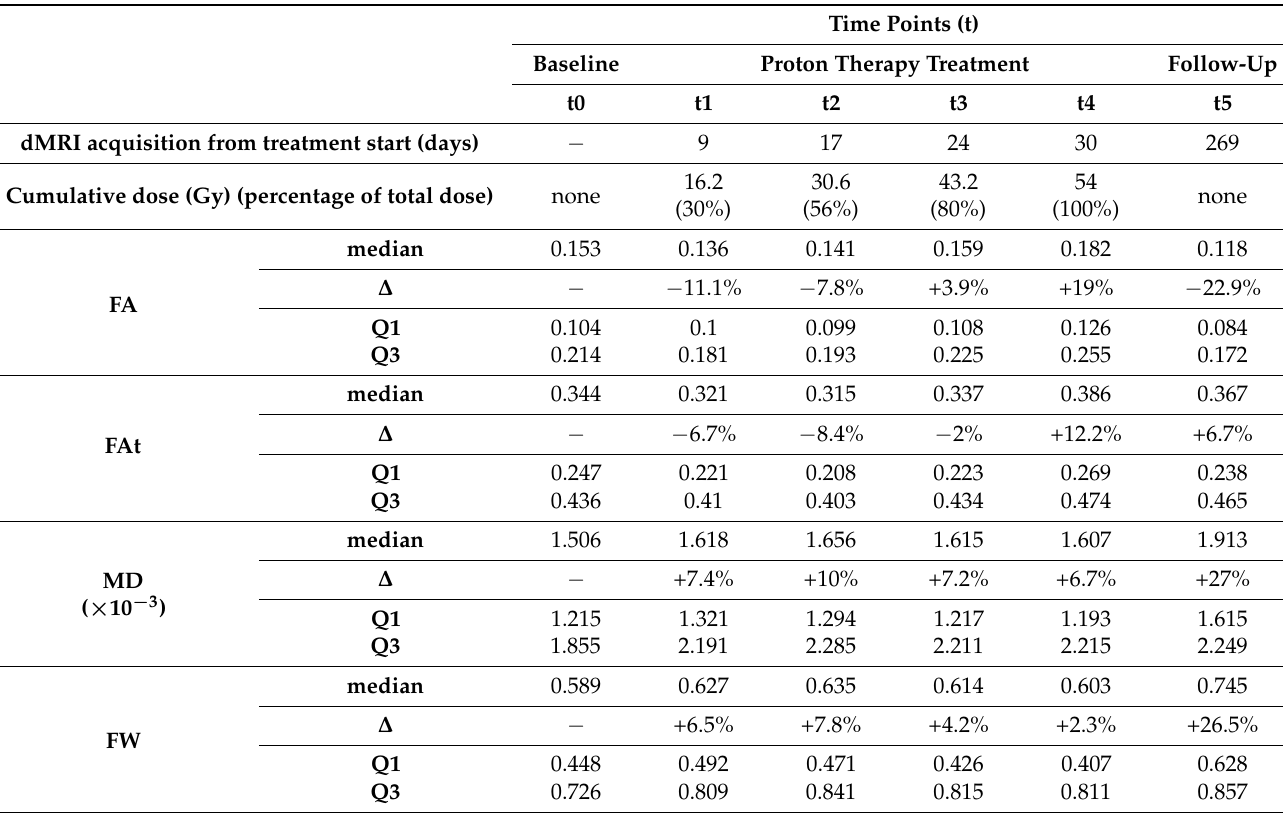
Table 1. Longitudinal quantification of brain tumor microstructural changes during and after proton therapy treatment. Each diffusion index reports the median value of the distribution within the whole tumor volume (including fluid voxels), the relative change of the median with respect to baseline ( ∆ ) with its 1st (Q1) and 3rd (Q3) quartile values. Time Points (t) Baseline Proton Therapy Treatment Follow-Up t0 t1